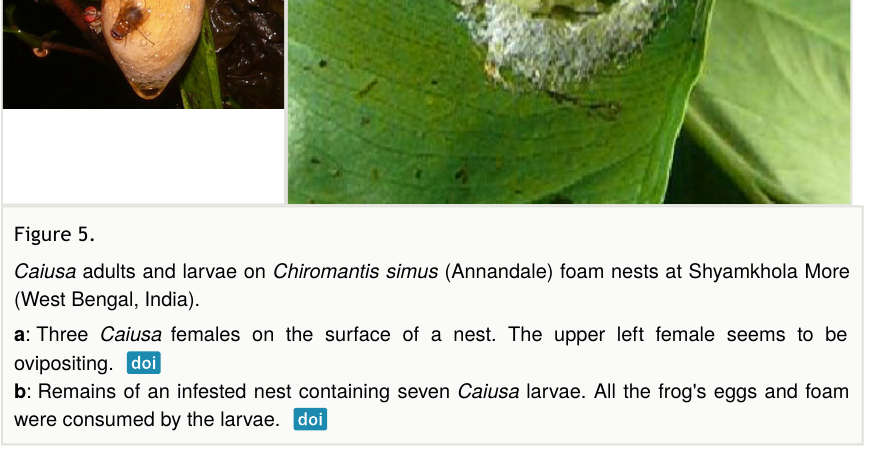
Abundance of Caiusa larvae in C. simus and P. leucomystax nests. The number of